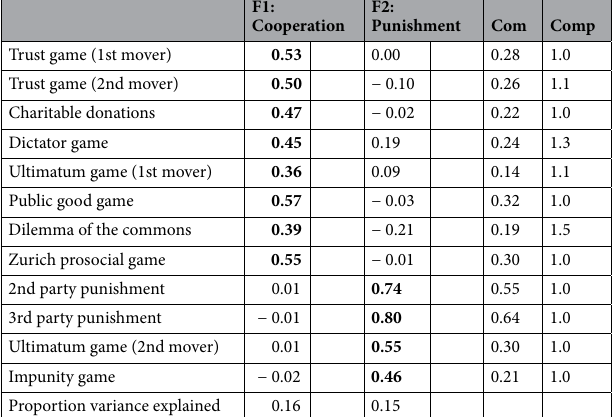
Table 1. Factor analysis of 12 economic variables: 2-factor solution. Standardized loadings (pattern matrix) based upon correlation matrix, communality (“Com”) and complexity (“Comp”) of each variable. Two factors, labeled “Cooperation” and “Punishment”, captured 31% of the total variance.